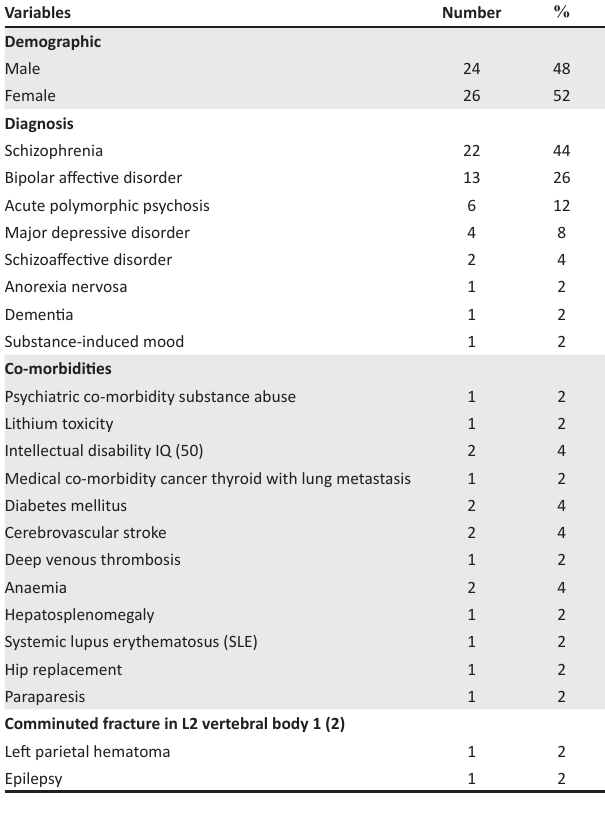
TABLE 1: Characteristics of the